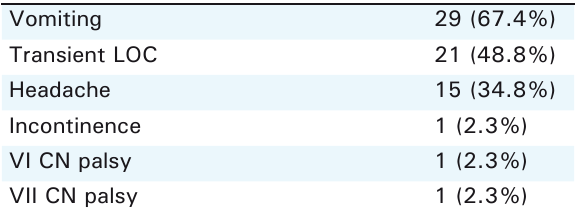
table 3. Clinical Presentation: